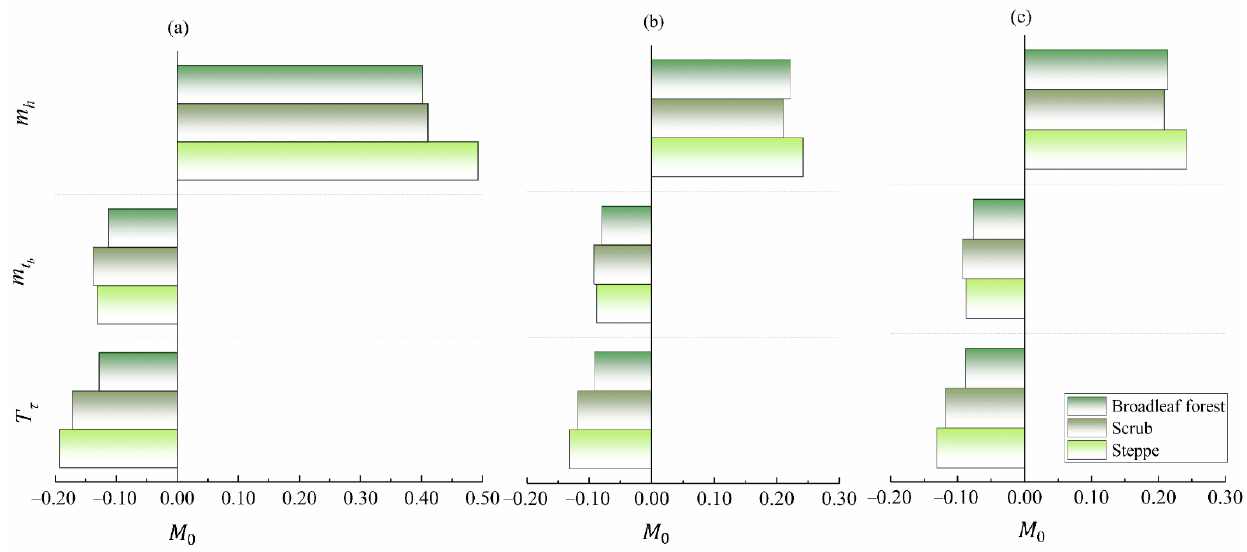
Figure 8. M 0 changes with the mean storm depth ( m h ), the mean time between storms ( m t temperature ( T τ ). In this study, m h changed from 11.26 to 20.13 mm, m t from 13.79 to 23.32 °C. Soil texture types: ( a ) Sandy loam; ( b ) loam; ( c ) loamy clay, clay loam, or sandy clay loam.